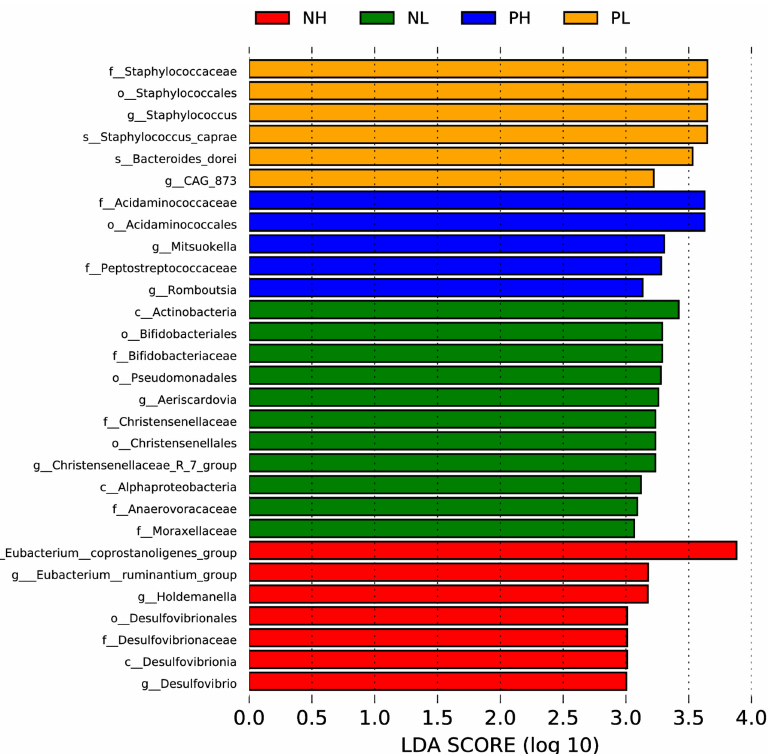
Figure 6. Effects of different moisture contents (adding 7.5 vs. 15% water) and enzyme additions (adding 4 kg/t α -amylase or not) to extruded corn on the phylotypes distribution in weaned piglets. LefSe bar representing differential abundant taxa in pig gut microbiome. NL, adding 7.5% water be- fore corn extrusion; NH, adding 15.0% water before corn extrusion; PL, adding 7.5% water and 4 kg/t α -amylase before corn extrusion; PH, adding 15% water and 4 kg/t α -amylase before corn extrusion.